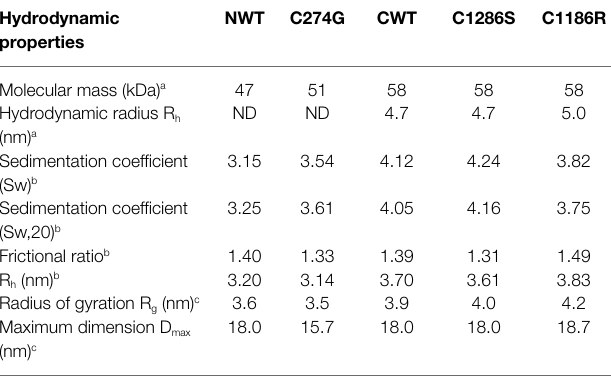
TABLE 1 | Experimental hydrodynamic results for LTBP4 C-terminal